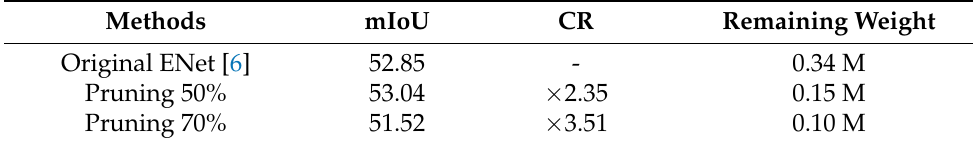
Table 6. Apply our method on ENet with a CamVid